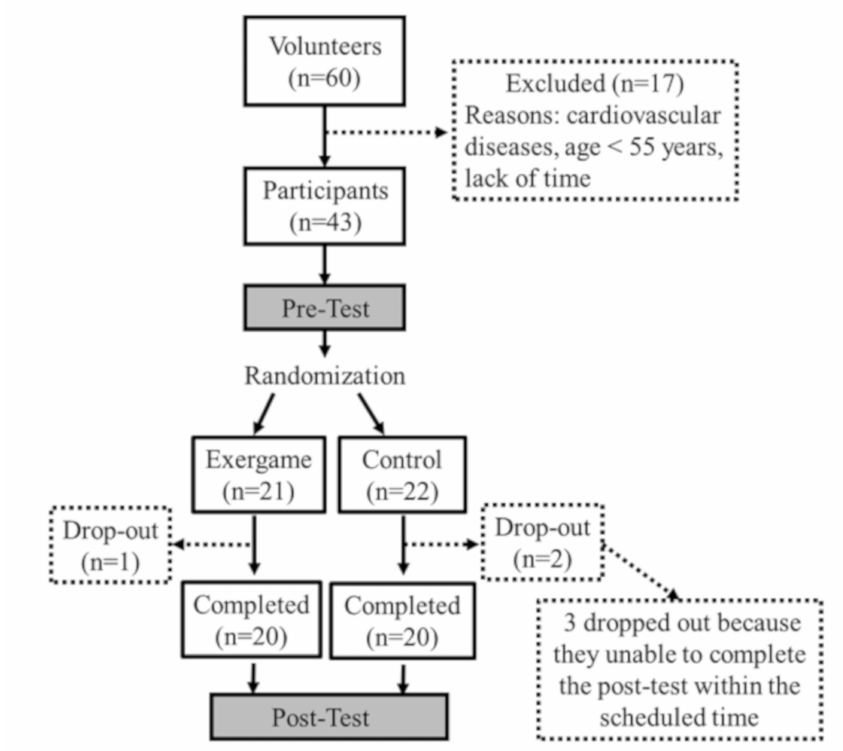
Figure 1. Flowchart of inclusion